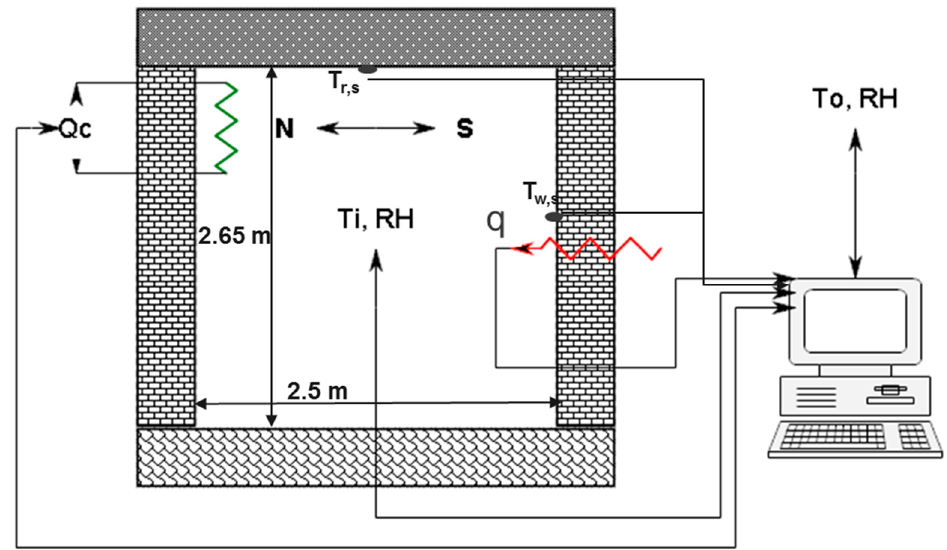
Figure 3. Instrumentation layout in pilot scale test cubicle.